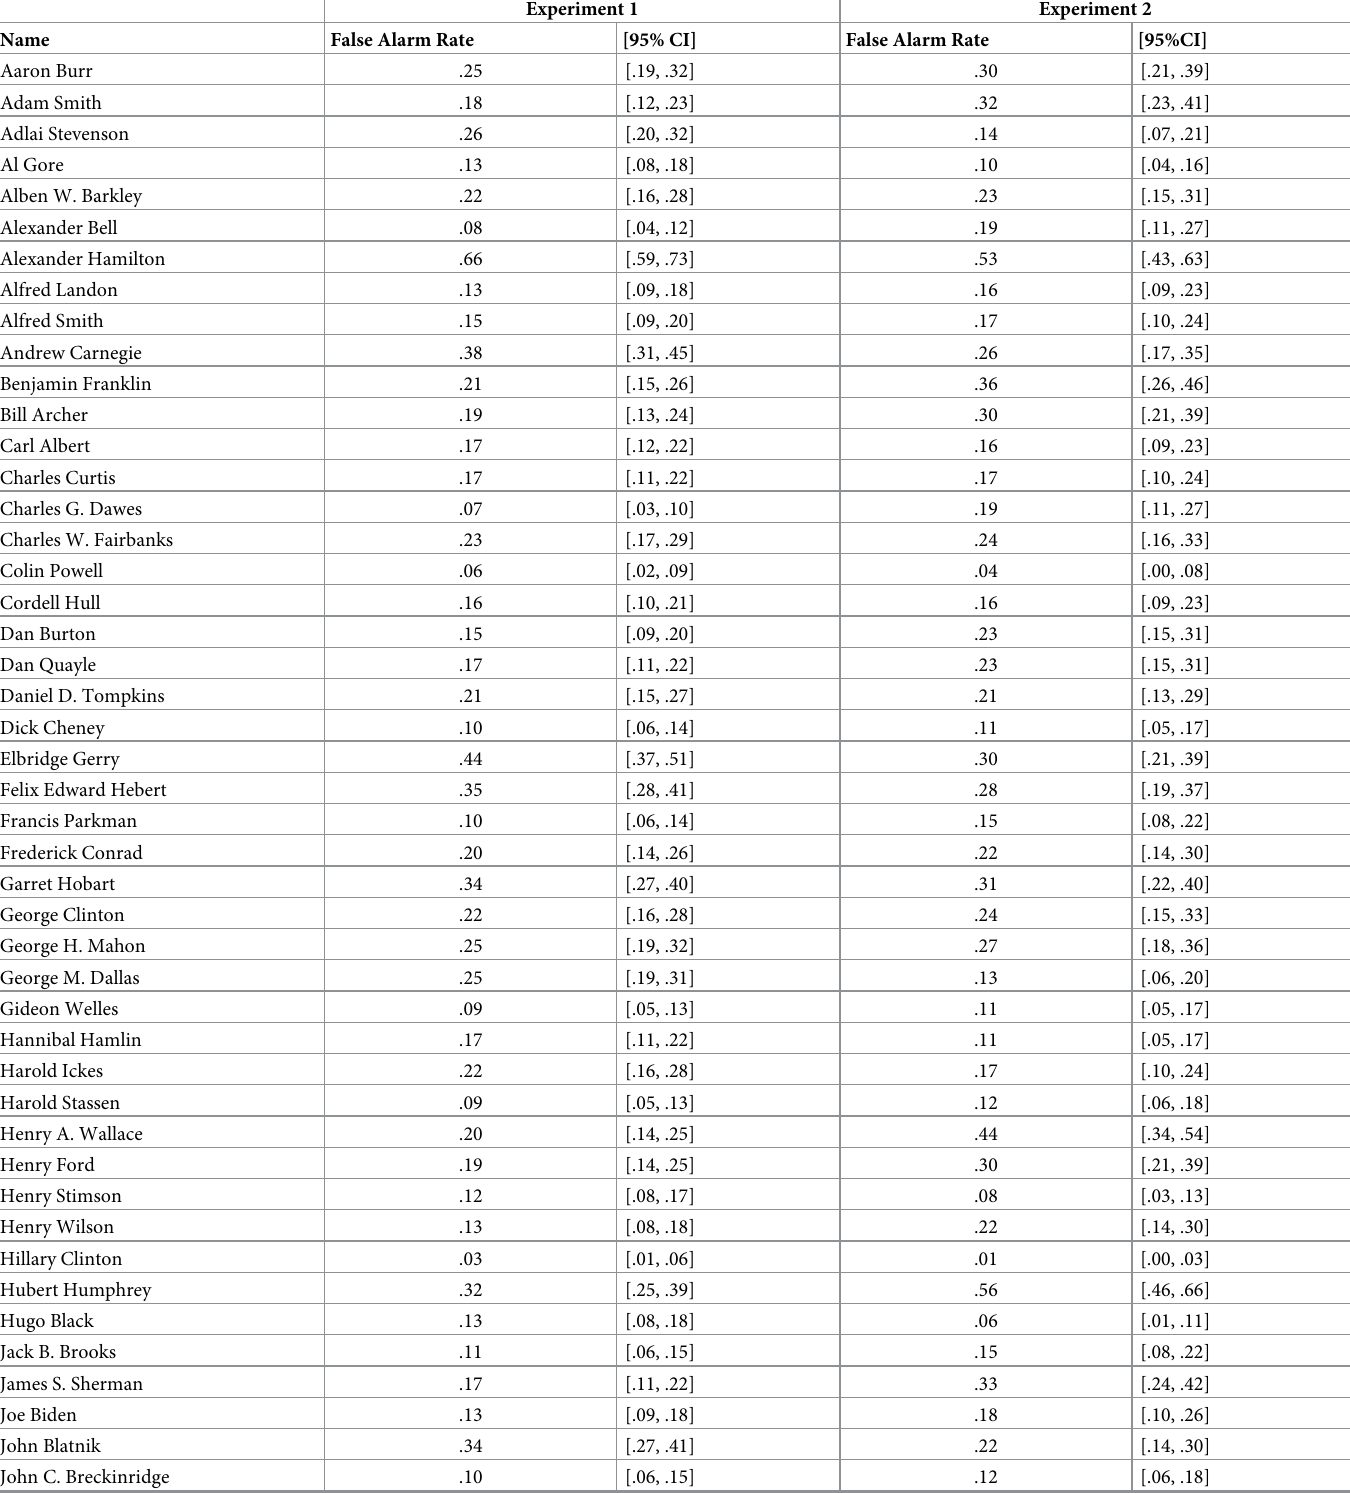
Table 3. Proportion of subjects who incorrectly identified nonpresidents as presidents in Experiments 1 and